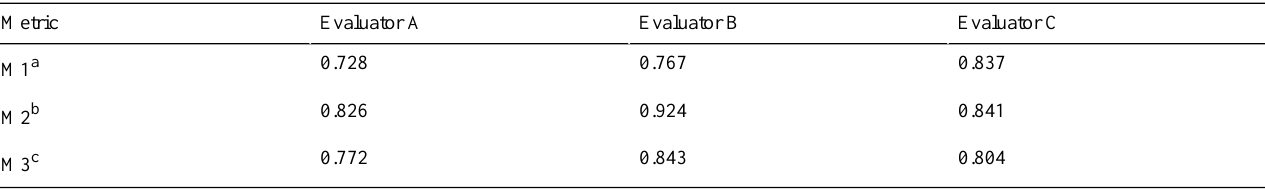
Table 10. Correlation matrix (Pearson correlation coefficients) of similarity approaches among evaluators for summaries according to the three metrics.